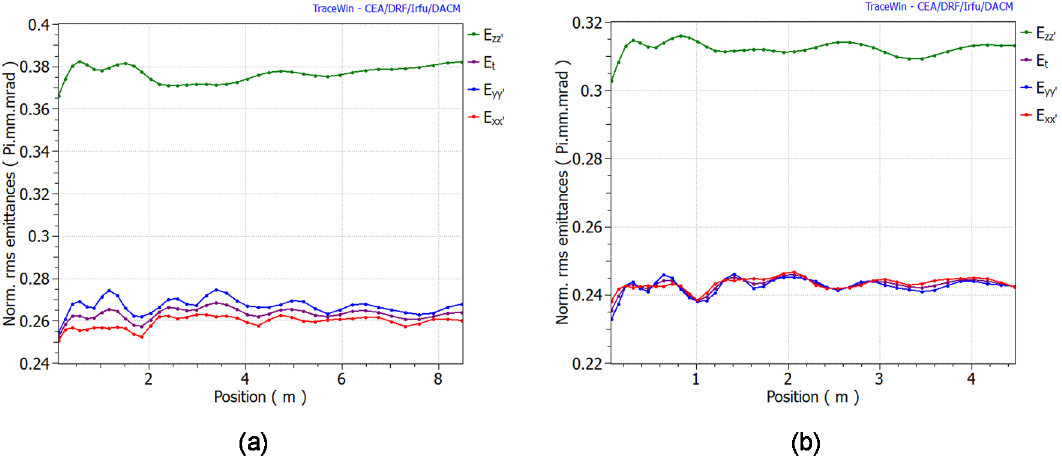
Figure 12. Emittance growths along both DTL linacs: ( a ) 162.5 MHz design, ( b ) 325 MHz design.